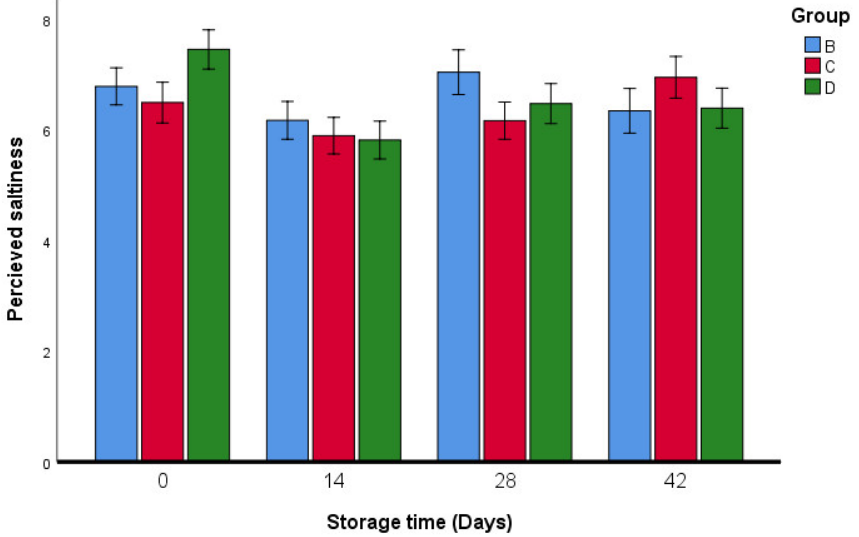
Figure 13. Saltiness sensory analysis of fresh oregano during storage period (42 days). Group B: (73.2% Fresh oregano, 15% Fresh Allium cepa , 20% corn oil, 1.8% salt), Group C: (61.9% Fresh oregano, 15% Fresh Allium cepa , 20% corn oil, 1.8% salt, 1.29% sumac “ Rhus coriaria ”), Group D: (59.2% Fresh oregano, 15% Fresh Allium cepa , 20% corn oil, 1.8% salt, 4% lactic Acid, ultimate pH 4.4.